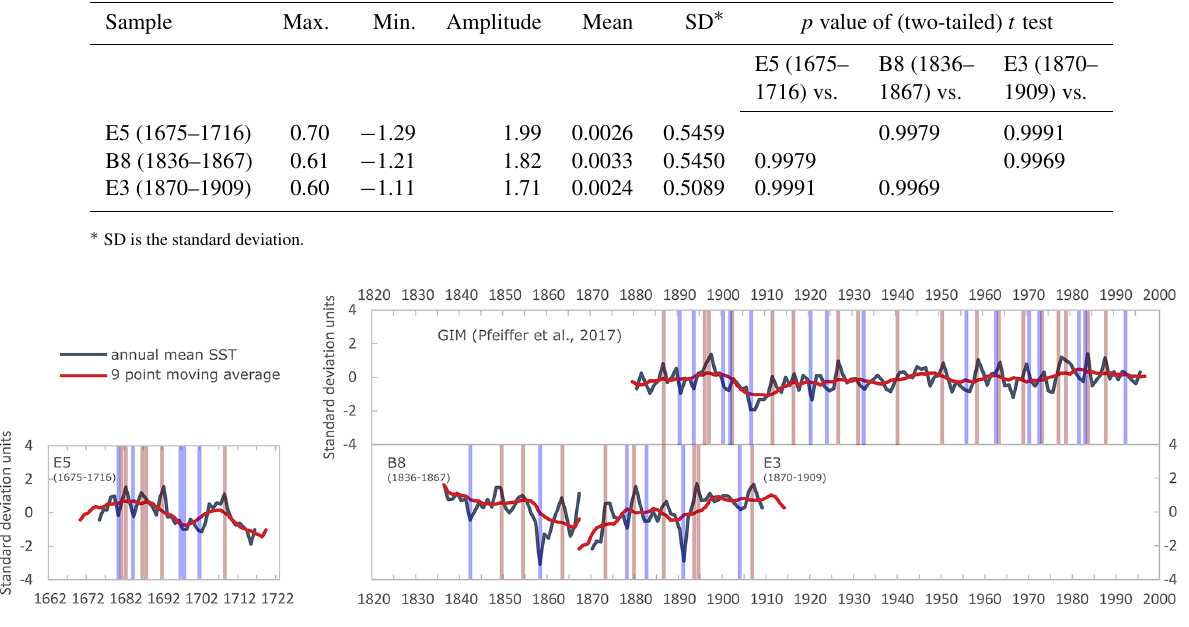
Figure 5. Annual SST anomalies for Chagos corals (this study and core GIM from Pfeiffer et al., 2009, 2017); red indicates El Niño, blue indicates La Niña, and shaded boxes indicate years used for the composite records (Figs. 7–9). Thick red lines are nine-point moving averages. See text Sect. 4.5 for how El Niño and La Niña events were